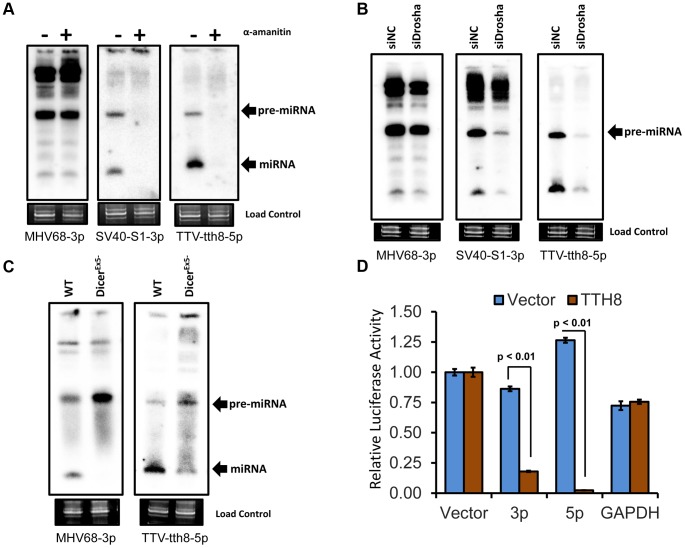
TTV tth8 miRNAs are generated by the canonical host miRNA biogenesis pathway.(A) Northern blot analysis of RNA from HEK293 cells transfected with MHV68-miR-M1-7 expression vector, SV40-miR-S1 TTV recombinant genome preparation, or wildtype TTV-tth8 genome preparation with or without treatment with the RNA pol II inhibitor α-amanitin. Ethidium bromide stained low molecular weight RNA is shown as a load control. (B) Northern blot analysis of RNA from HEK293T cells co-transfected with MHV68-miR-M1-7, SV40-miR-S1, or TTV-tth8-miR-T1 expression vectors and either Drosha siRNA (siDrosha) or negative control siRNA (siNC). Ethidium bromide stained low molecular weight RNA is shown as a load control. (C) Northern blot analysis of RNA from either DLD1 (WT) or DLD1DicerEx5- (DicerEx5-) cells transfected with either MHV68-miR-M1-7 or TTV-tth8-miR-T1 expression vectors. Ethidium bromide stained low molecular weight RNA is shown as a load control. (D) RISC reporter assay for TTV-tth8-miR-T1. HEK293 cells were co-transfected with either empty miRNA expression vector (Vector) or TTV-tth8-miR-T1 expression vector (TTH8) and both control firefly luciferase reporter and Renilla luciferase based reporter plasmids with vector UTR (Vector), two sites perfectly complementary to TTV-tth8-miR-T1-5p (5p), two sites perfectly complementary to TTV-tth8-miR-T1-3p (3p), or control 3′UTR reporter with GAPDH 3′UTR (GAPDH). The average relative Renilla luciferase activity normalized to firefly luciferase activity of three replicates is shown. Error bars indicate SD of three replicates and p-values were calculated using Student's t-test.